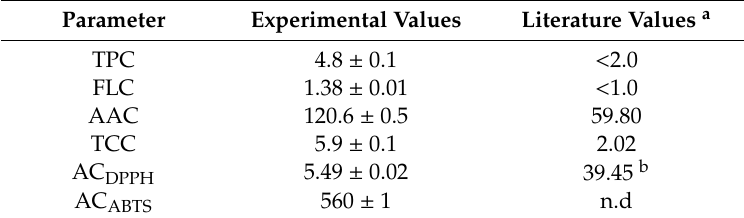
Table 3. Phytochemical characterization of optimized kiwi juice pomace (mean ±